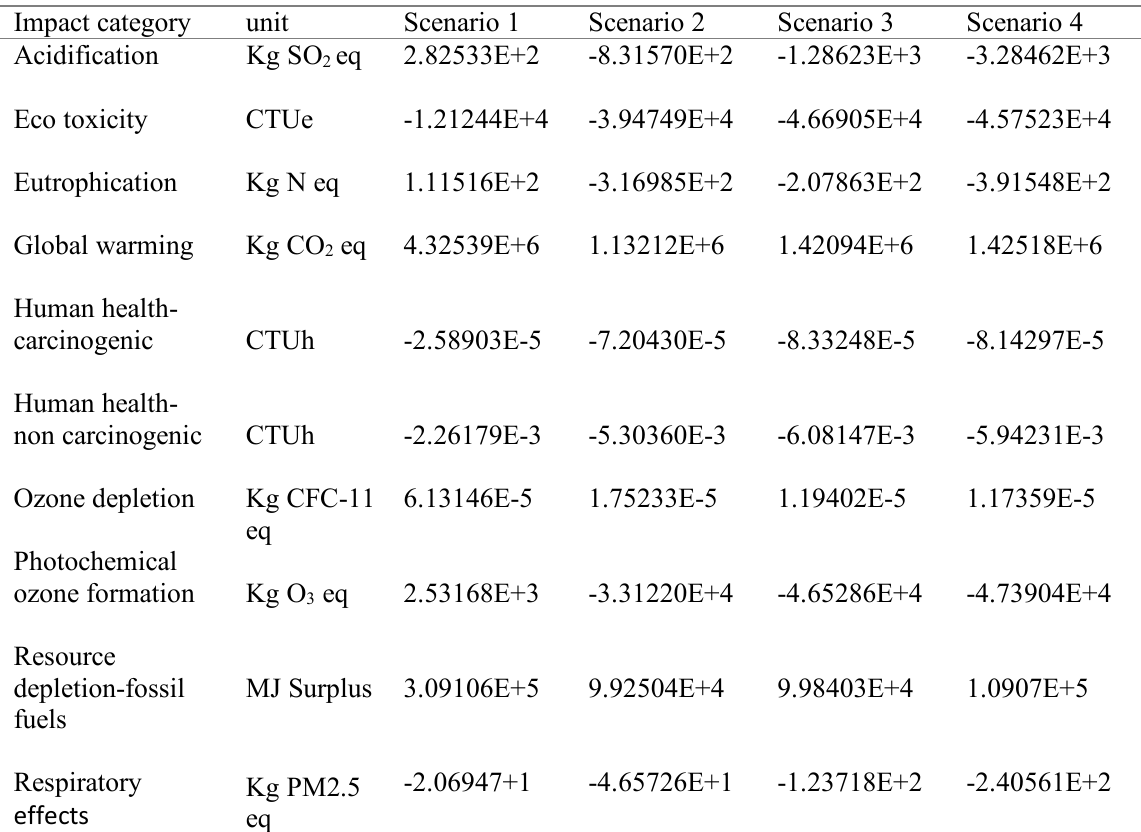
Table 6 . Results of environmental impact assessment of scenarios in each impact categories based on TRACI2014